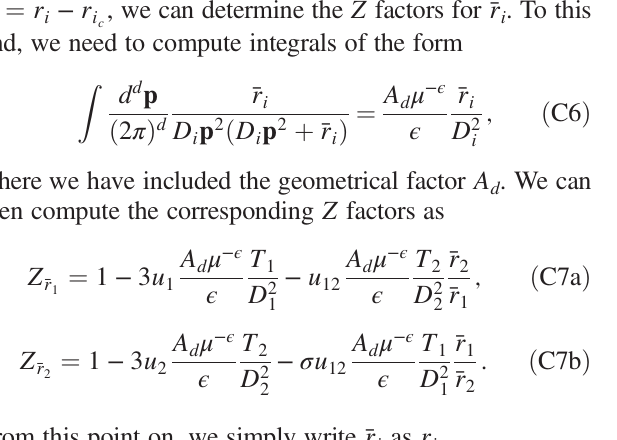
˜ ϕ – (h) u ϕ 2 ϕ 12 1 1 . Analogous diagrams for r 2 2